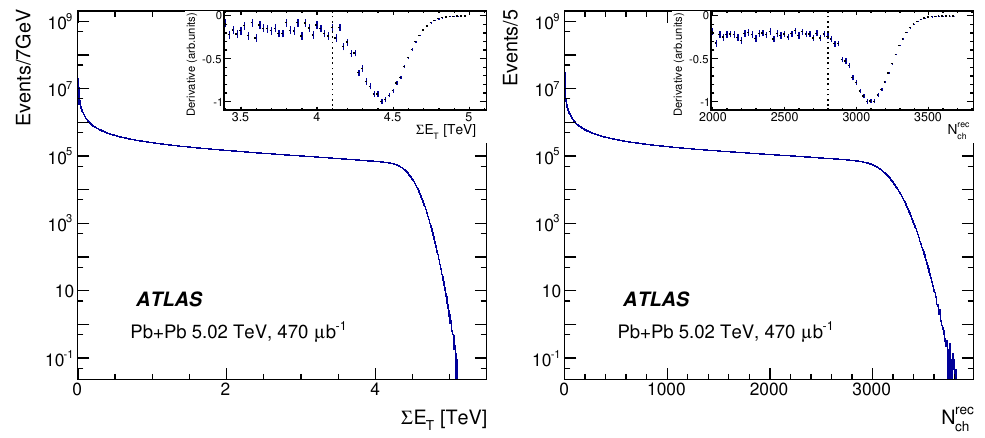
Figure 2 . The distribution of (cid:6) E T (left panel) and the distribution of N rec the Pb+Pb collisions. The insert panels show the (cid:12)rst-order derivative of the corresponding one- dimensional distributions. The vertical dashed line indicates the location, ((cid:6) E T ) knee = 4 : 1 TeV and ( N rec ) knee = 2800 respectively, where the derivatives for (cid:6) E T and N rec ch values of the derivatives have been rescaled to a minimum value of (cid:0)